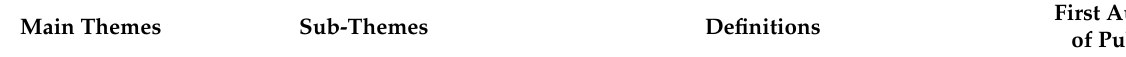
Table 2. Definitions of “home cooking” are indicated in the included